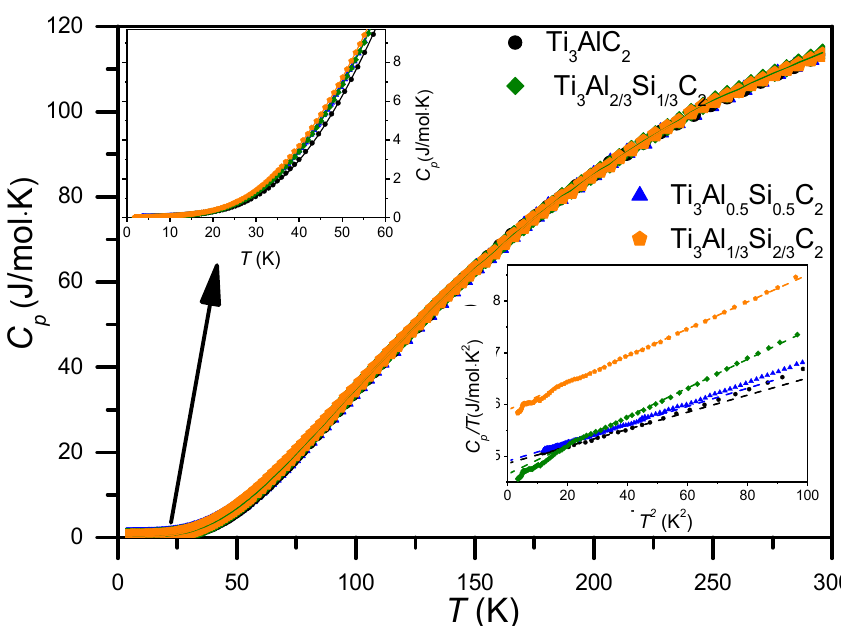
Figure 7. Temperature dependencies of the specific heat ( C p ) of Ti 3 AlC 2 , and Ti 3 Al 1 − x Si x C 2 com- pounds. Fits (solid lines) represent Equation (1). The top inset shows the expanded low T range. The bottom inset shows the low T range as C p / T vs. T 2 plots. Linear fits to the data in the inset (dashed lines) were used to estimate the Debye temperature ( Θ D ) and the Sommerfeld coefficient ( γ ) of the compounds.